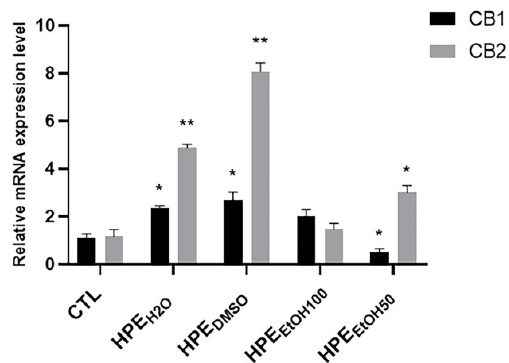
Figure 3. E ff ects of all HPE extracts on CB1 and CB2 mRNA expression level in human primary FLSs. After 24 h treatment with 0.1 mg / mL of Harpagophytum procumbens root extract (HPE) dissolved in deionized water (HPE H2O ), DMSO (HPE DMSO ), 100% v / v EtOH (HPE EtOH100 ), and 50% v / v EtOH (HPE EtOH50 ), cells were harvested and mRNA was extracted and analyzed by RT-PCR. CB1 and CB2 receptor mRNA levels were reported as relative mRNA expression level with respect to 18S mRNA (2 − ∆∆ Ct method). Results are expressed as mean ± S.E.M. of data obtained by three di ff erent experiments. Statistical significance was * p < 0.05; ** p <